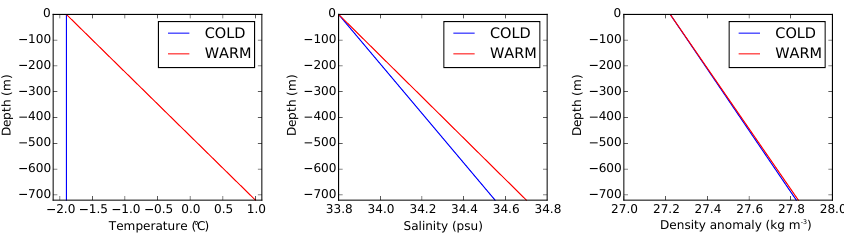
Figure 6. WARM and COLD temperature, salinity and density profiles used in all five ISOMIP + experiments. In Ocean1, the COLD profile specifies the initial condition and the WARM profile is used in the restoring, while in Ocean2 the profiles are switched. Ocean3 uses both WARM initial conditions and restoring whereas Ocean4 uses both COLD initial conditions and restoring. The WARM profiles were designed to qualitatively approximate observations in the Amundsen Sea Embayment near Pine Island Glacier (Dutrieux et al., 2014). The COLD profile is at the surface freezing temperature at all depths and has a salinity such that the densities of the WARM and COLD profiles are nearly identical.